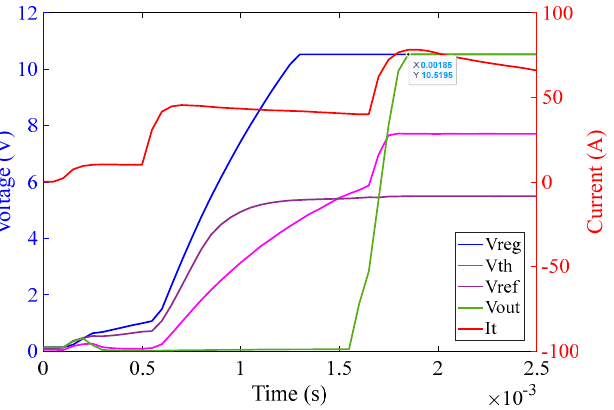
Figure 24. Activation time of the 1 Ω burden circuit at 60 A(rms) input current with 30° phase angle.